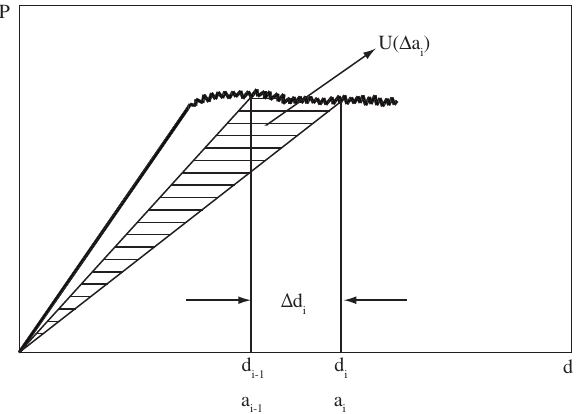
), corresponding to an increase in i . i